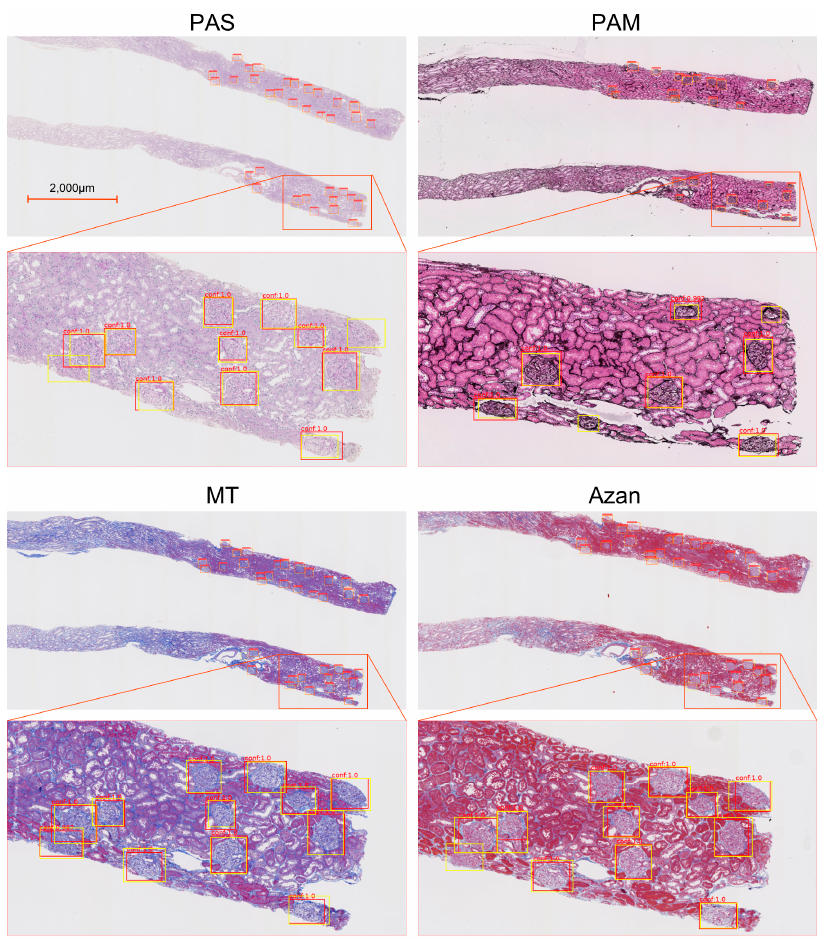
Figure 3. Images showing glomerular detection results for four different stains. The yellow frames show the areas annotated manually, and the red frames are the areas proposed by Faster R ‐ CNN. PAS, periodic acid ‐ Schiff; PAM, periodic acid ‐ methenamine silver; MT, Masson trichrome.